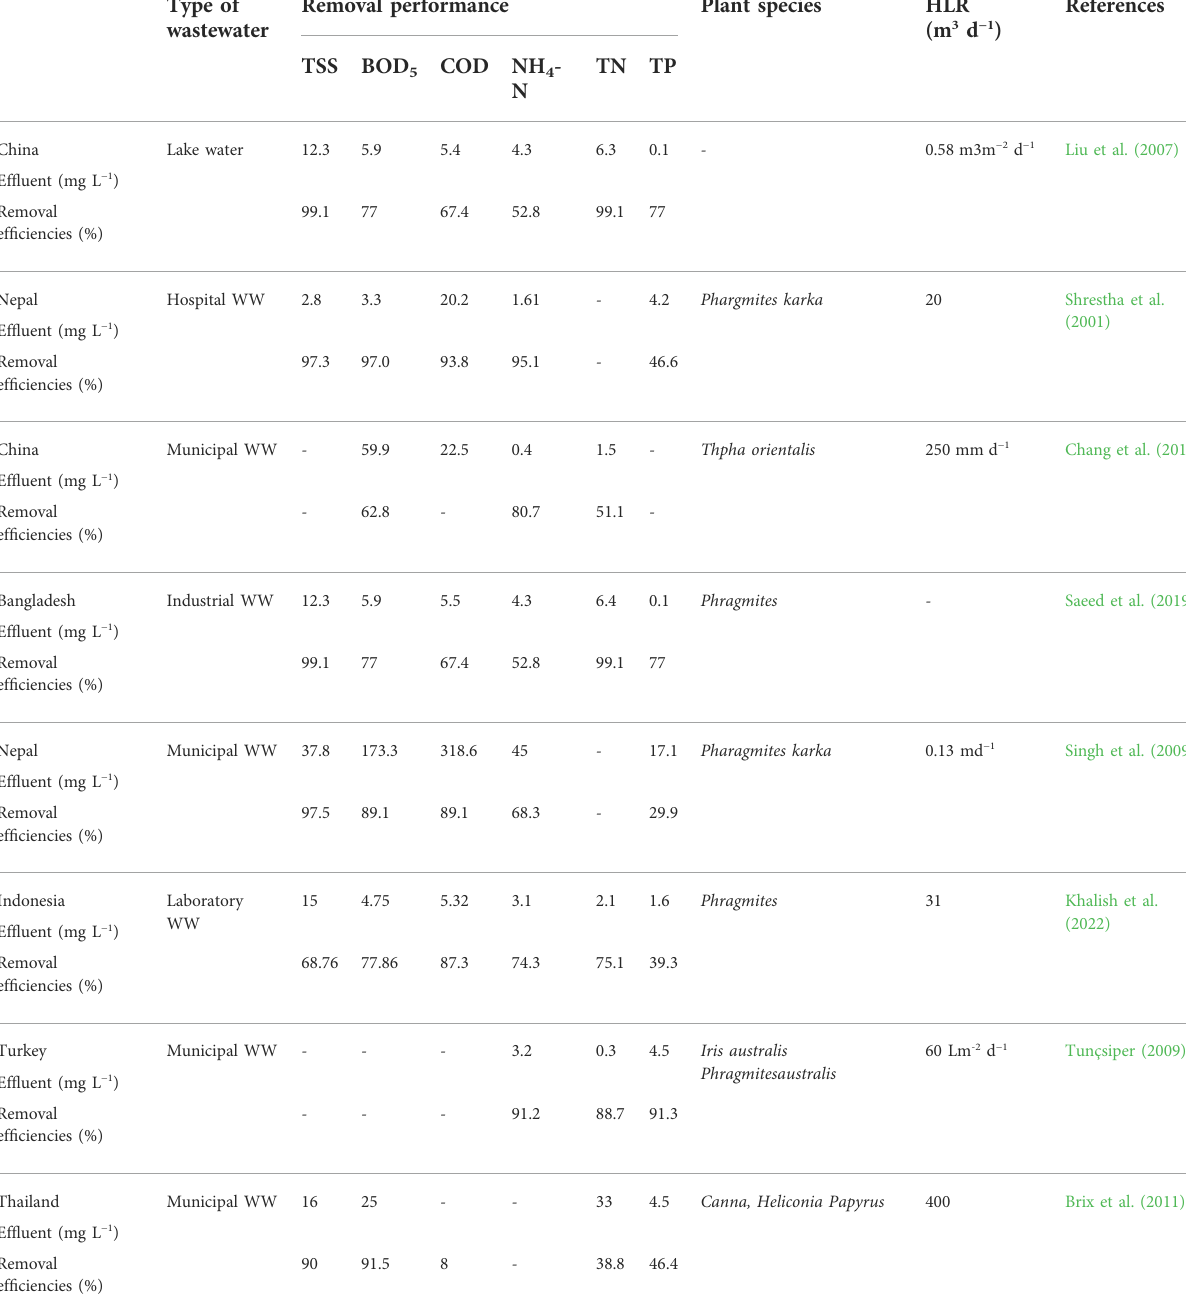
TABLE 4 An overview of the hybrid systems ’ operating characteristics and treatment performances in Asian